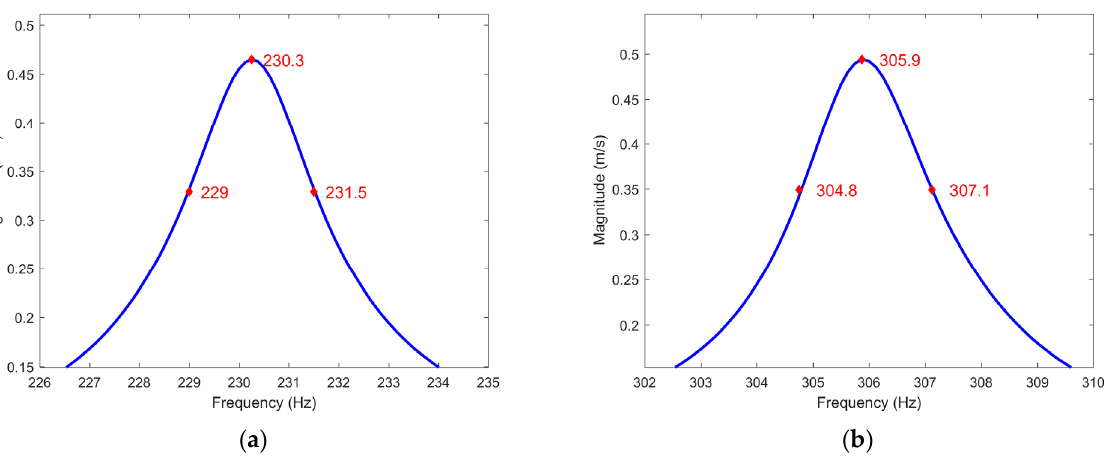
Figure A4. The half-bandwidth method for modal loss factor extraction for ( a ) 5th mode; ( b ) 6th mode (see Table 2 for details).